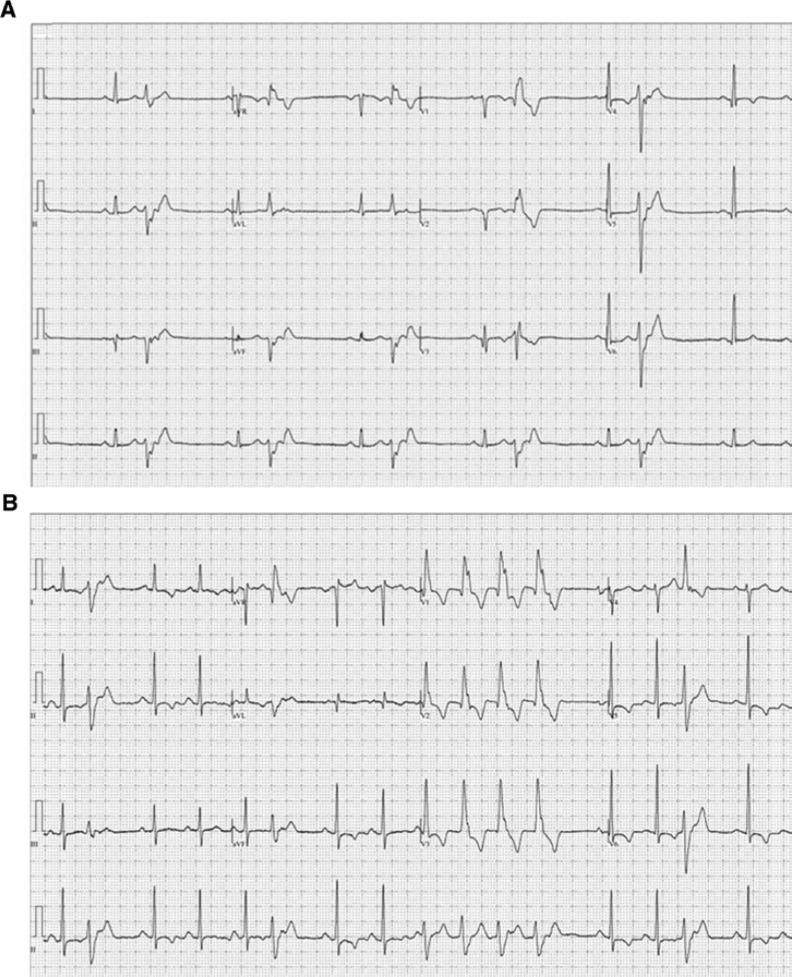
Surface ECGs of patients. A: Surface ECGs of patients with posteromedial papillary muscle VA. B: Surface ECGs of patients with anterolateral papillary muscle VA. These ECGs demonstrate the morphology and the variable presentation from isolated PVCs to the salvos of the VA. ECG: electrocardiogram; PVCs: premature ventricular contractions; VA: ventricular arrhythmia.